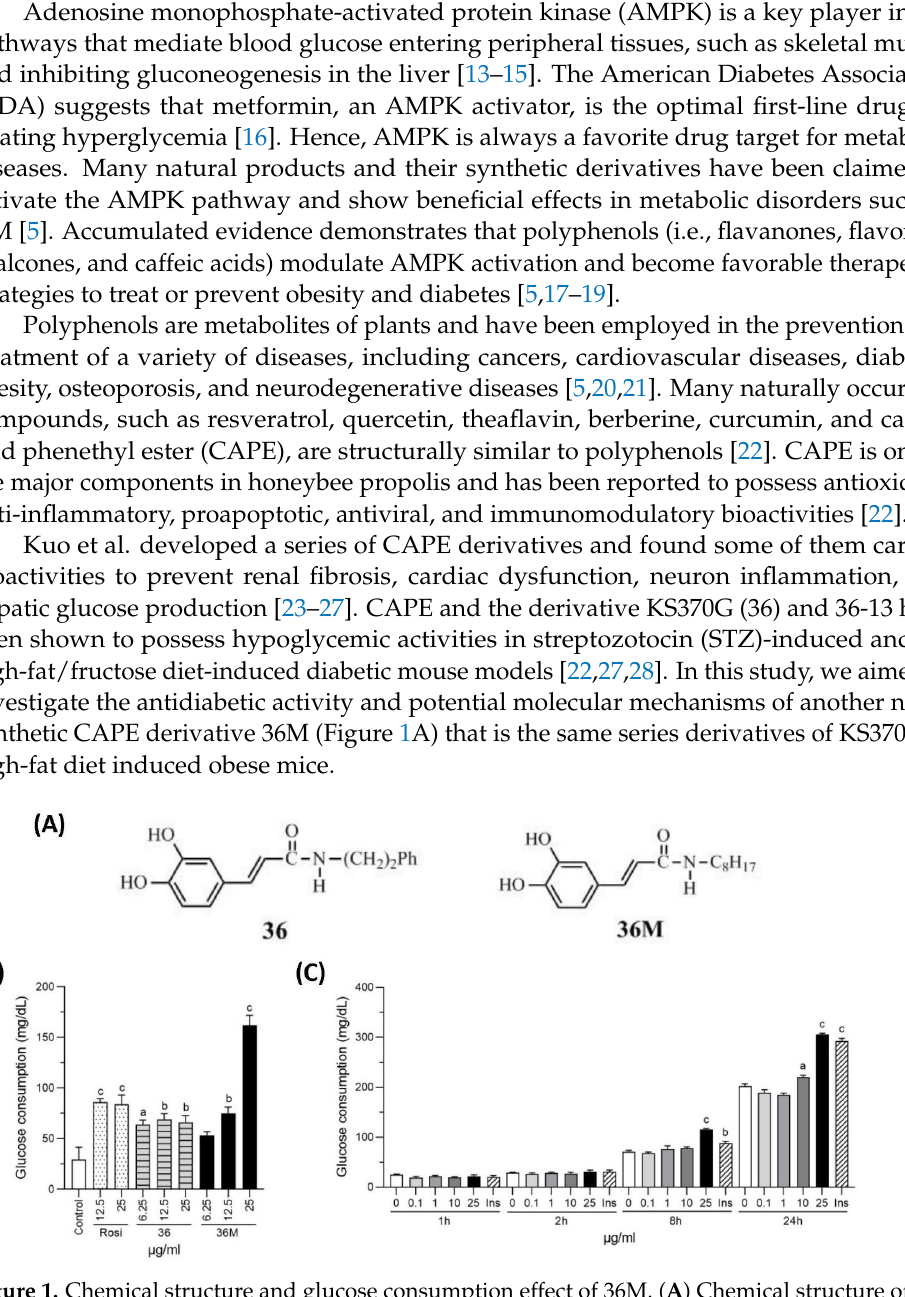
Figure 1. Chemical structure and glucose consumption effect of 36M. ( A ) Chemical structure of 36 and 36M. ( B ) Effect of culture medium glucose consumption in 3T3-L1 adipocytes. The cells were treated with 6.25, 12.5, or 25 μg/mL of rosiglitazone (Rosi), 36 or 36M for 24 h. ( C ) Effect of culture medium glucose consumption in C2C12 myotubes. The cells were stimulated with 0, 0.1, 1, 10, or 25 μg/mL of 36M or 0.32 μM of insulin (Ins) for 1, 2, 8 , and 24 h. Data are mean ± SE (n = 3). Compared to control or 0; a: p < 0.05; b: p < 0.01; c: p < 0.001.